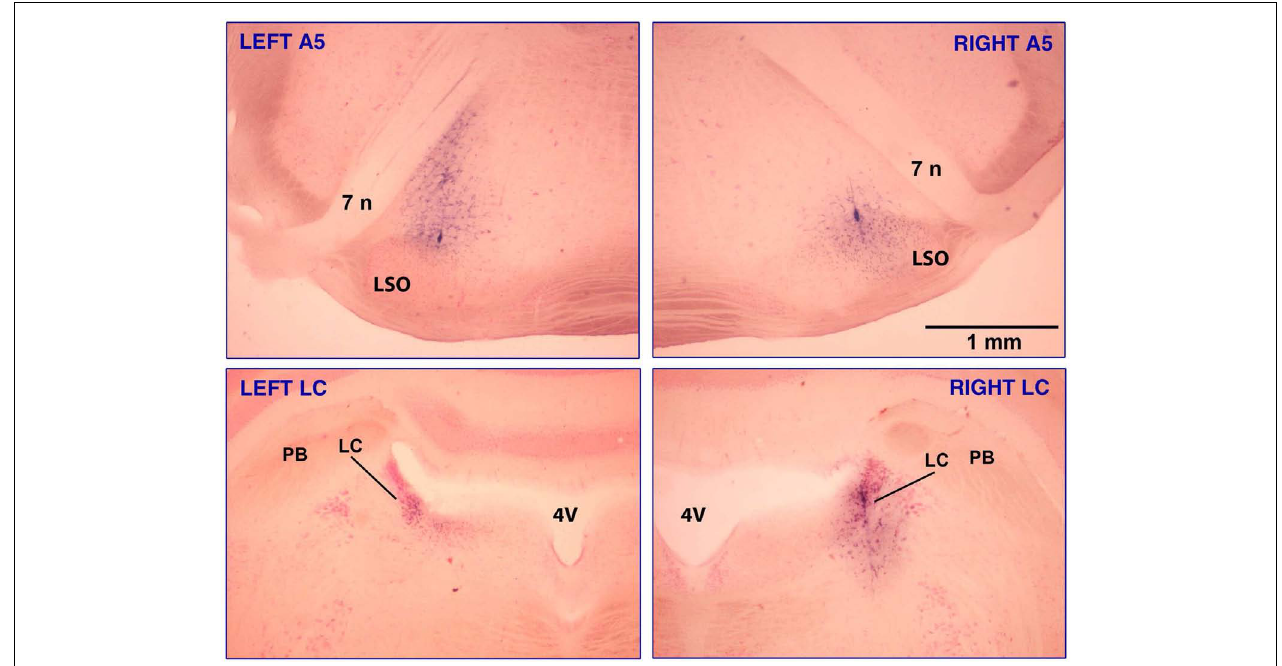
nerve (7n) and the lateral superior olivary nucleus (LSO) and some also occur along the dorsolateral border of the LSO (Fenik et al., 2002). Intense blue staining marking the track of the injection pipette can be seen in the bottom right and both top panels.The calibration bar in the top-right panel applies to all panels. Abbreviations: 4V, 4th ventricle; PB, parabrachial